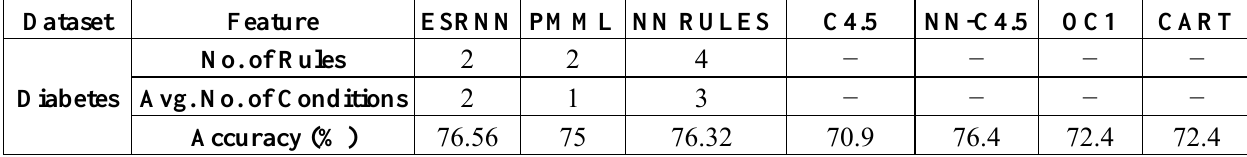
Table 10. Performance comparison of the ESRNN with other algorithms for the diabetes